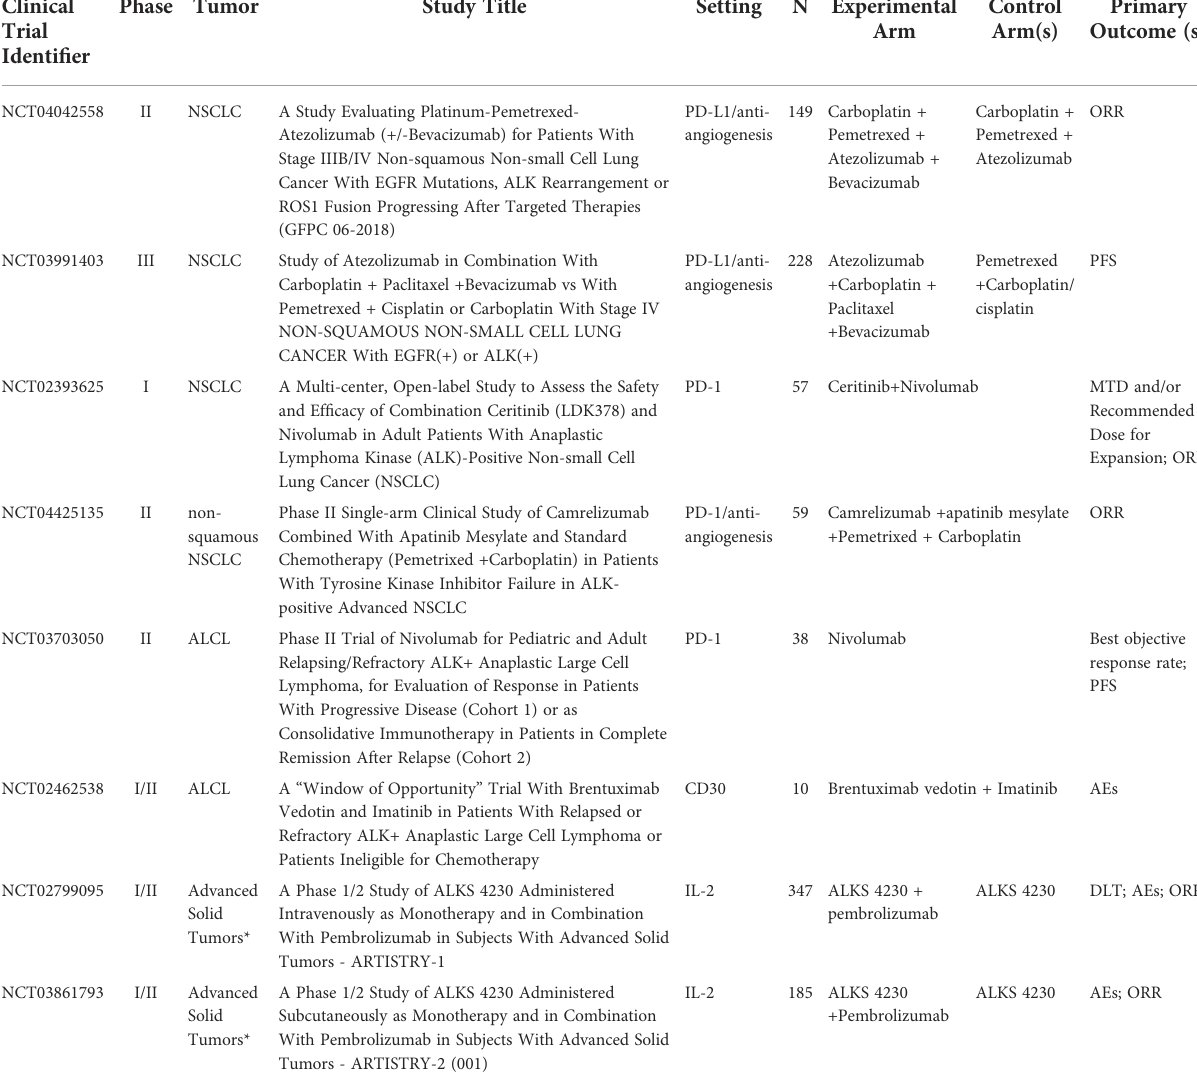
TABLE 2 Summary of ongoing trials with immunotherapy in ALK+ tumors (source: www.clinicaltrials.gov, last accessed: 30 Mar 2022). Clinical